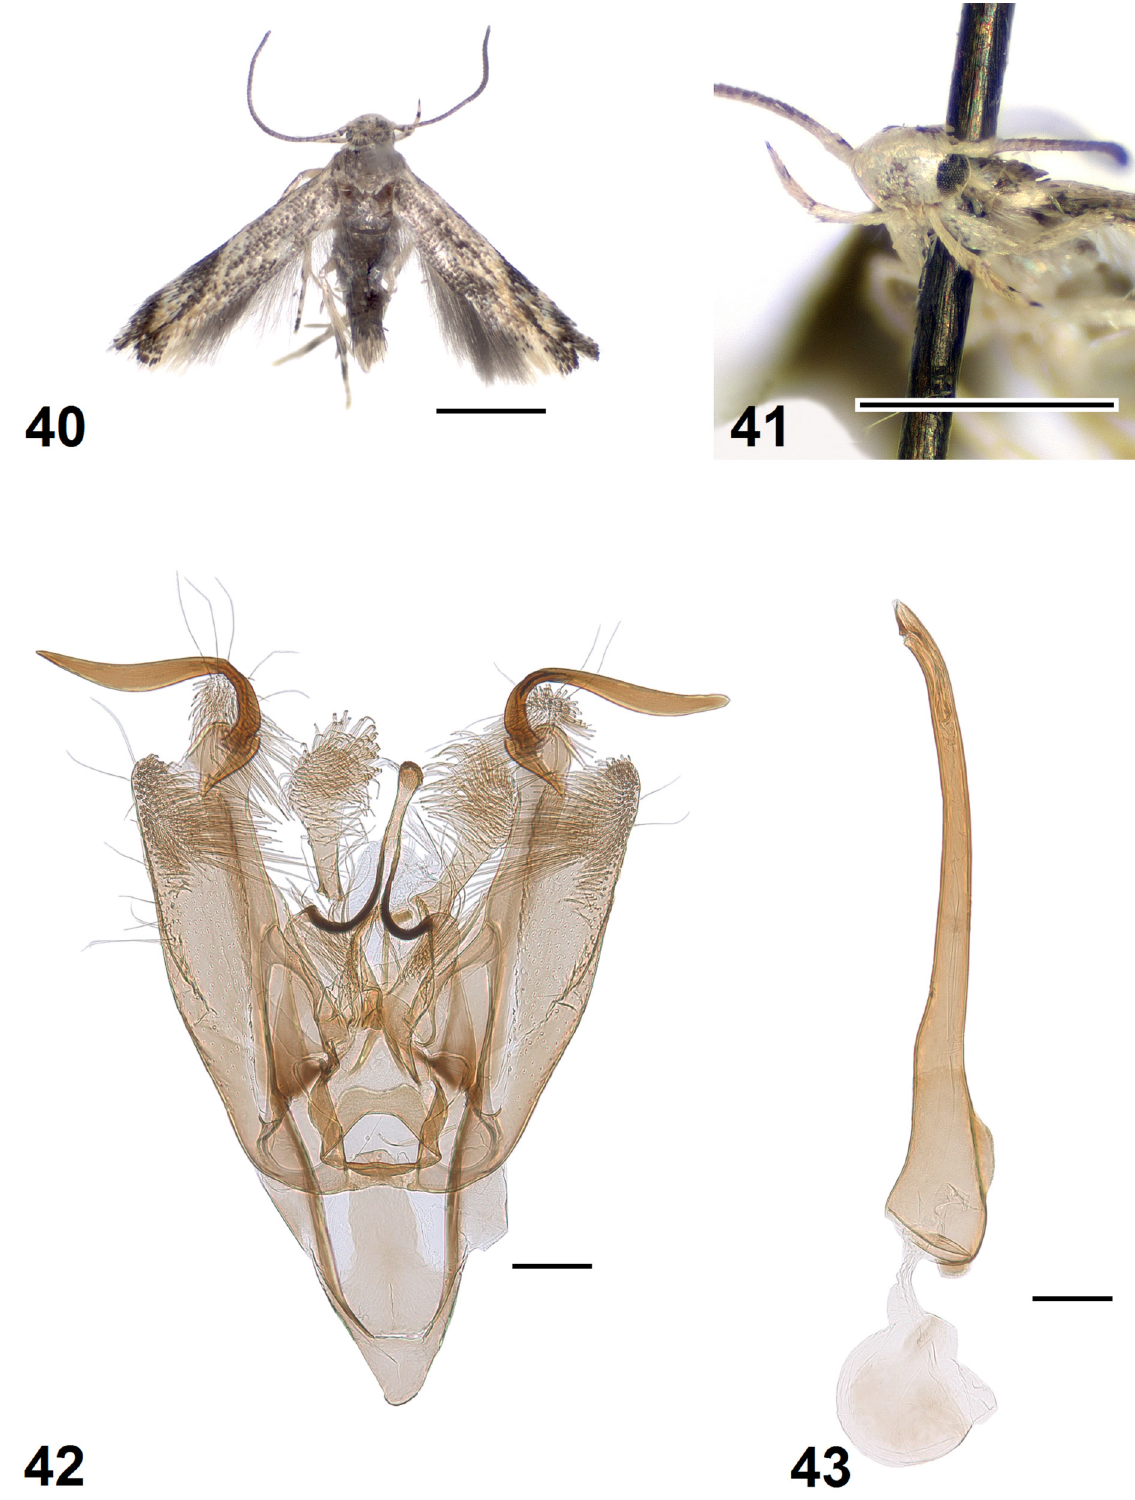
Figs 40–43. Elachista capricornis Sruoga & Kaila sp. nov. 40–41 . Male paratype. 40 . Adult. 41 . Head, latero-frontal view. 42–43 . Holotype, ♂ (MZH VS2/21.11.18). 42 . General view of male genitalia (phallus removed). 43 . Phallus. Scale bars: 40–41 = 1 mm; 42–43 = 0.1